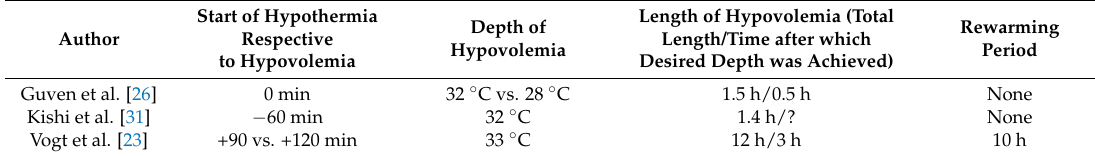
Table 2. Specific characteristics of hypothermic